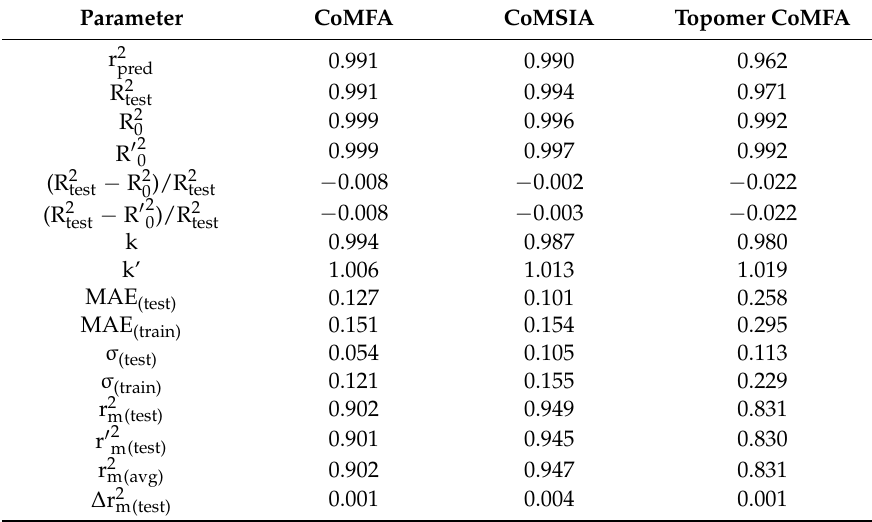
Table 2. The validation statistical results for the optimal CoMFA, CoMSIA, and Topomer CoMFA